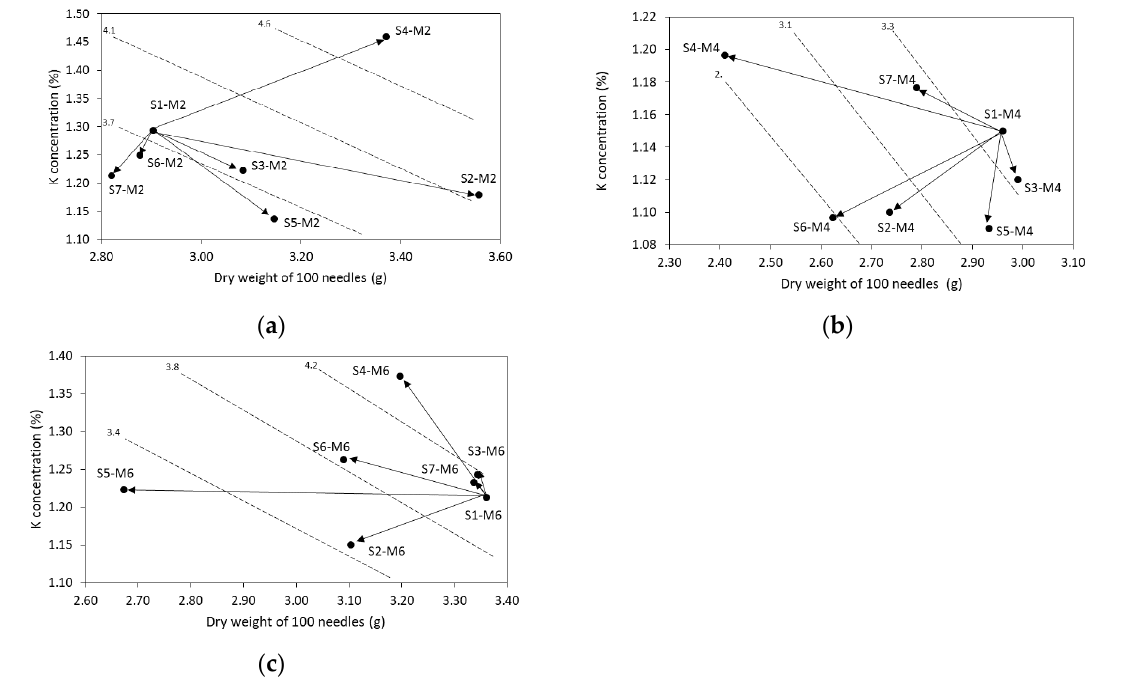
Figure 5. Vector nomograms of the potassium concentration (K) in the foliage of Pinus engelmannii, produced in seven substrates with the addition of three doses of fertilization; ( a ) 2 g L − 1 Multicote ® ; ( b ) 4 g L − 1 Multicote ® and ( c ) 6 g L − 1 Multicote ® .